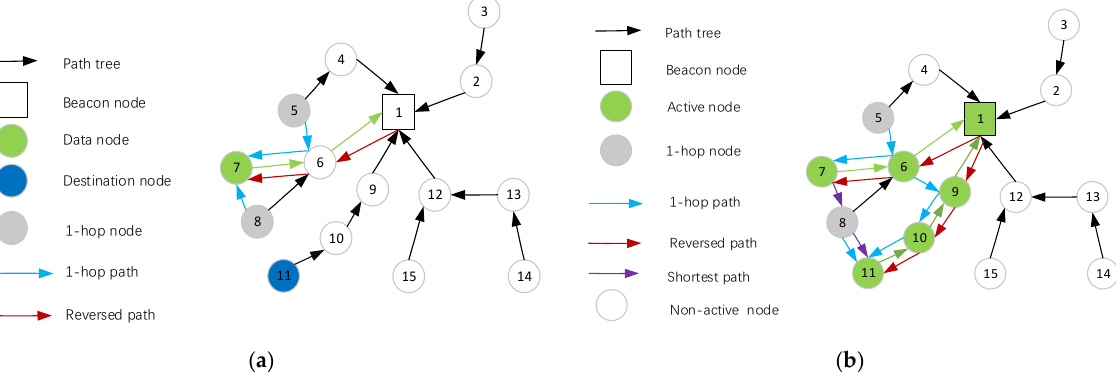
Figure 5. ( a ) Schematic diagram of source node path establishment process. ( b ) Schematic diagram of destination nodepath establishment process.